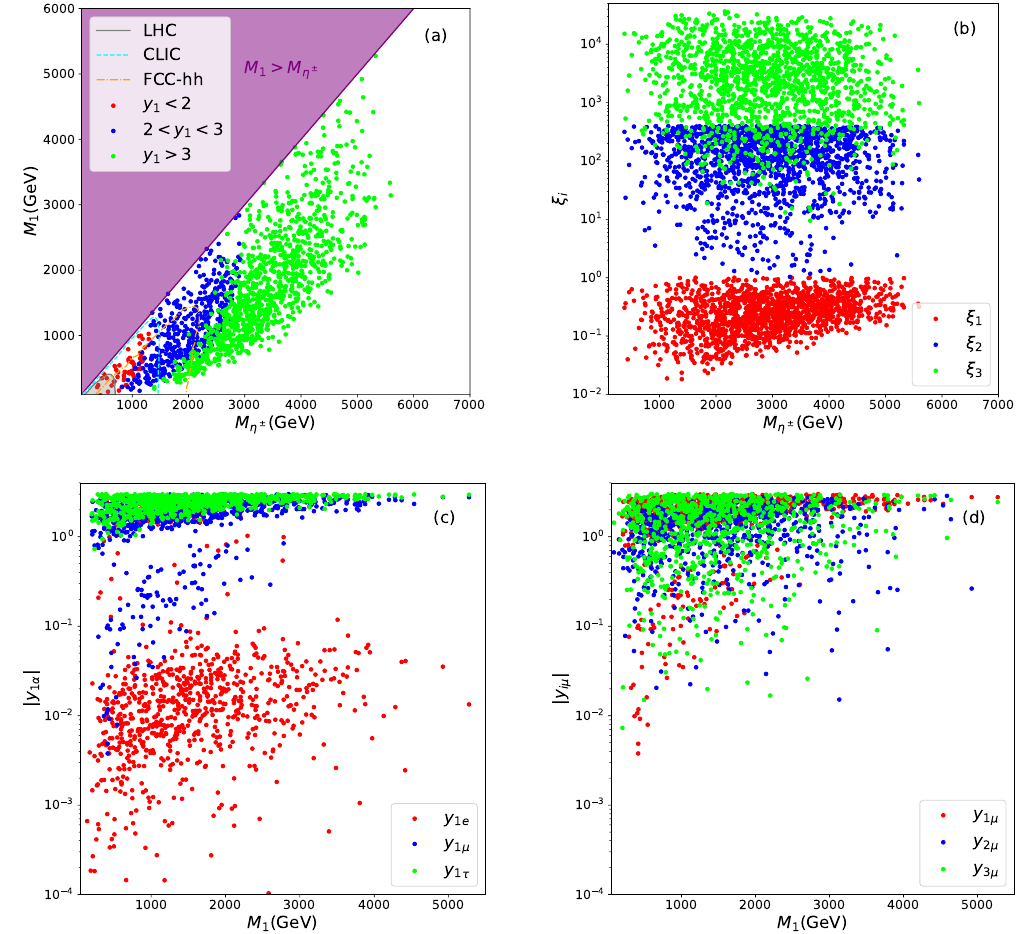
Figure 2 . The allowed samples under constraints from lepton flavor violation and dark matter relic density. The gray region in panel (a) is excluded by LHC [39]. The cyan and orange lines correspond to the future limits by CLIC and FCC-hh